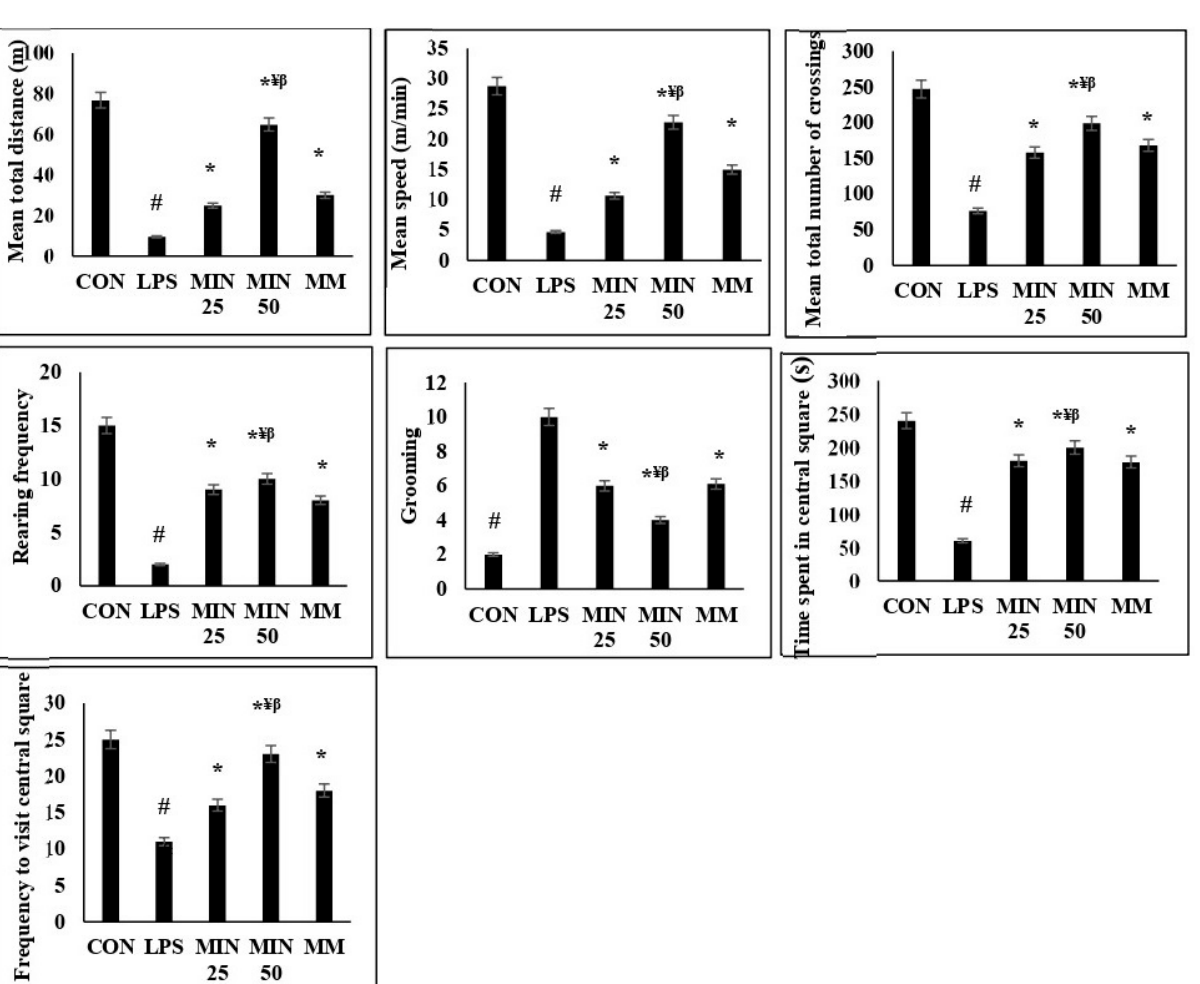
Figure 2. Mean of the total distance (1), speed (2), the number of line crossings (3), rearing (4), grooming (5), time spent in the central square (6), and frequency of visiting the central square (7) of all experimental groups during the open-field test. One-way ANOVA test followed by Bonferroni post hoc test. Values are expressed as mean ± SEM. n = 10. (F (1, 36) = 9.39; # p < 0.05) versus control group; (F (1, 36) = 4.13; * p < 0.05) versus LPS group, (F (1, 36) = 4.06; ¥ p < 0.05) versus MIN 25, (F (1, 36) = 7.55; β p < 0.05) versus MM.